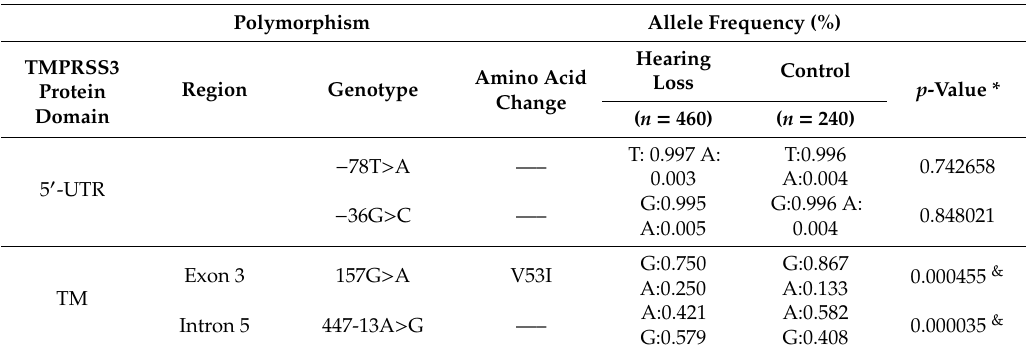
Table 1. Polymorphisms of TMPRSS3 gene in the